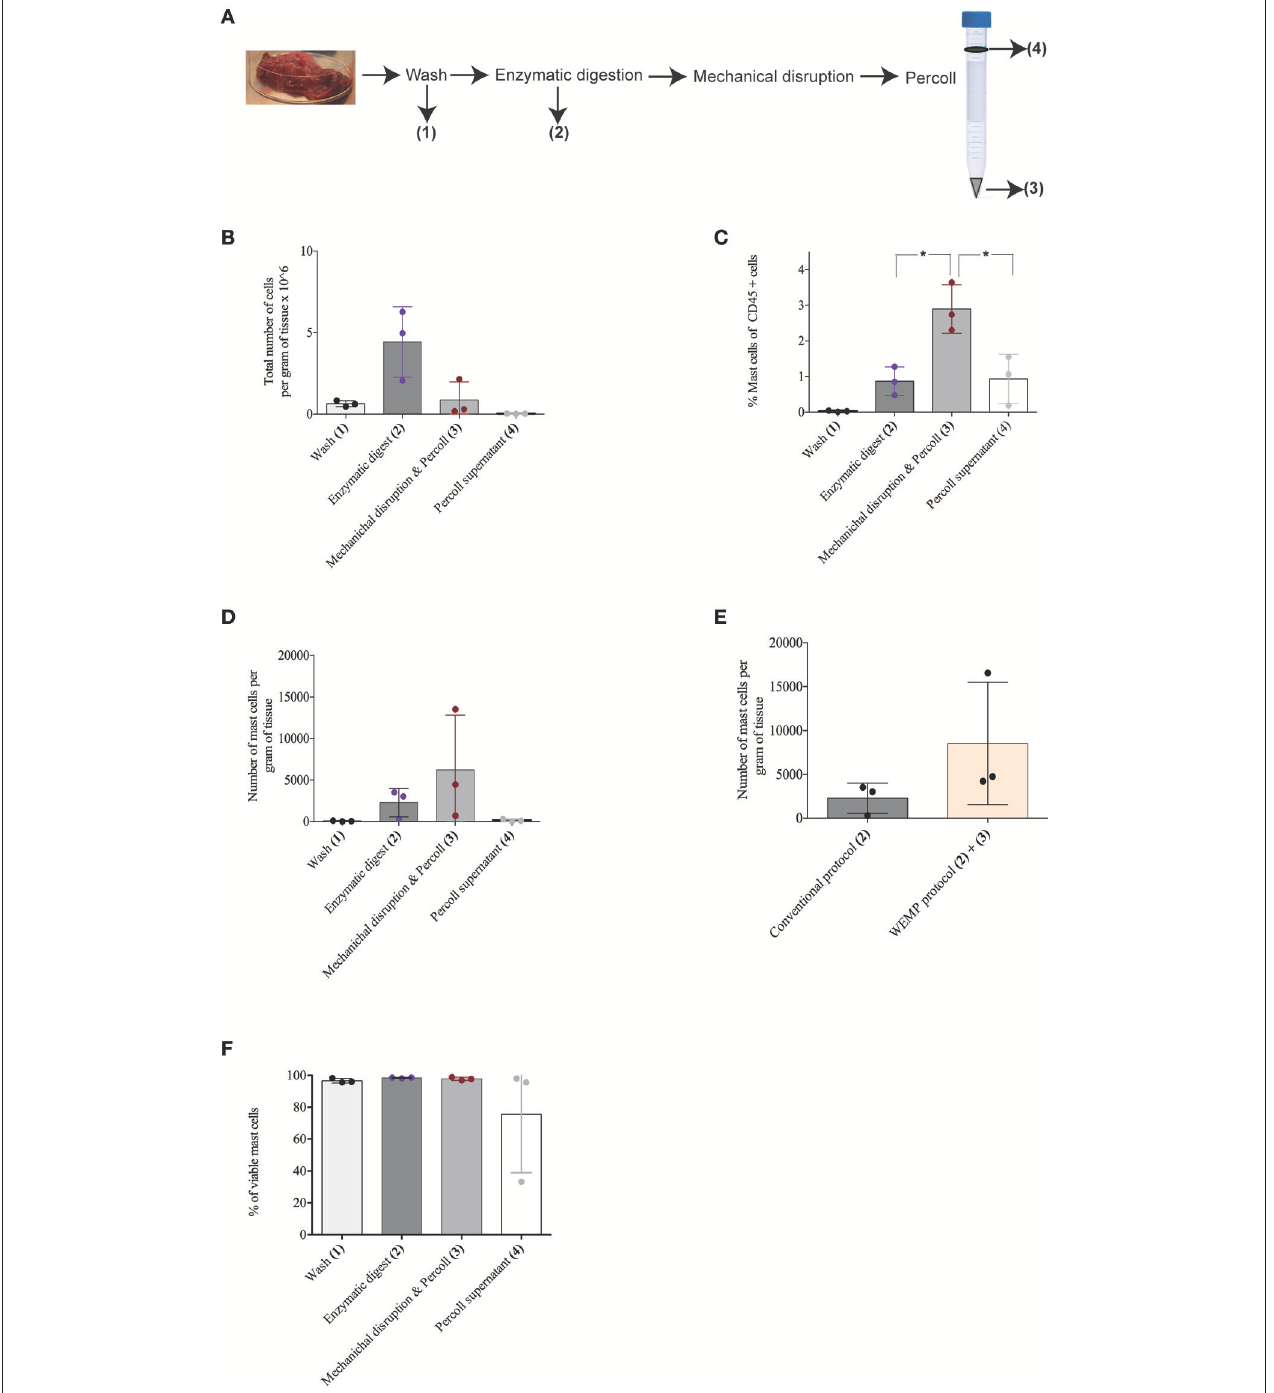
FIGURE 4 | Human lung mast cell yield during different steps of protocol. (A) Cells isolated and frequency, number of mast cell analyzed from different steps of the protocol—WEMP. (B) Total number of cells from different steps of the protocol counted using microscope. Cells were collected from different steps of the protocol—wash, enzymatic digest, cell pellet and supernatant after mechanichal disruption followed by gradient centrifugation (Percoll purification). (C) Mast cells of CD45 + population from different steps of the protocol analyzed by flowcytomtery. (D) Number of mast cells per gram of tissue from different steps of protocol counted using microscope. (E) Number of mast cells per gram of tissue compared between conventional and WEMP protocol counted using microscope (by combining different steps of protocol). (F) Percentage of viable mast cells during different steps of the protocol analyzed by flowcytometry. * P < 0.05.